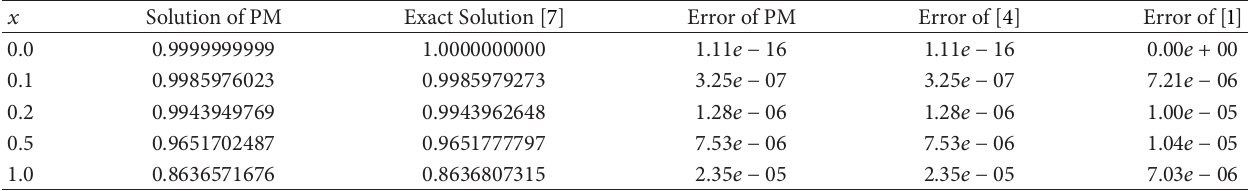
Table 2: The exact and approximated solution of Example 4 together with the error comparisons for 𝑁 = 10